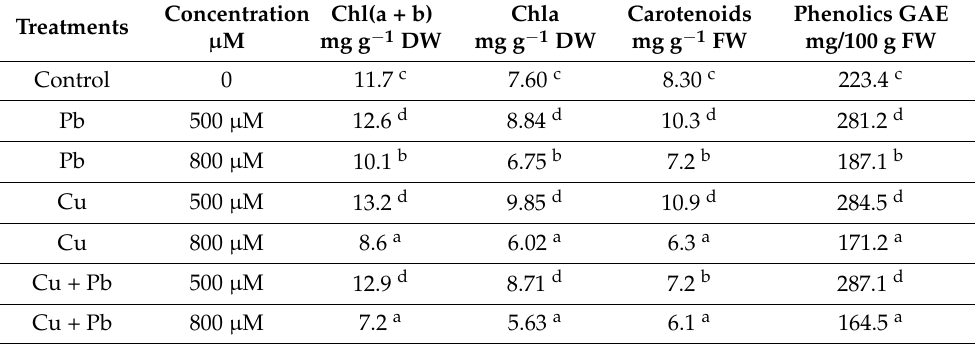
Table 2. Effects of Cu(SO 4 ) 2 and Pb(NO 3 ) 2 on chlorophylls (Chl (a + b), Chl a), carotenoids and Phe- nolics (GAE; mg/100 g FW) of Citrus aurantium L. (Nine replications) plants. Quality